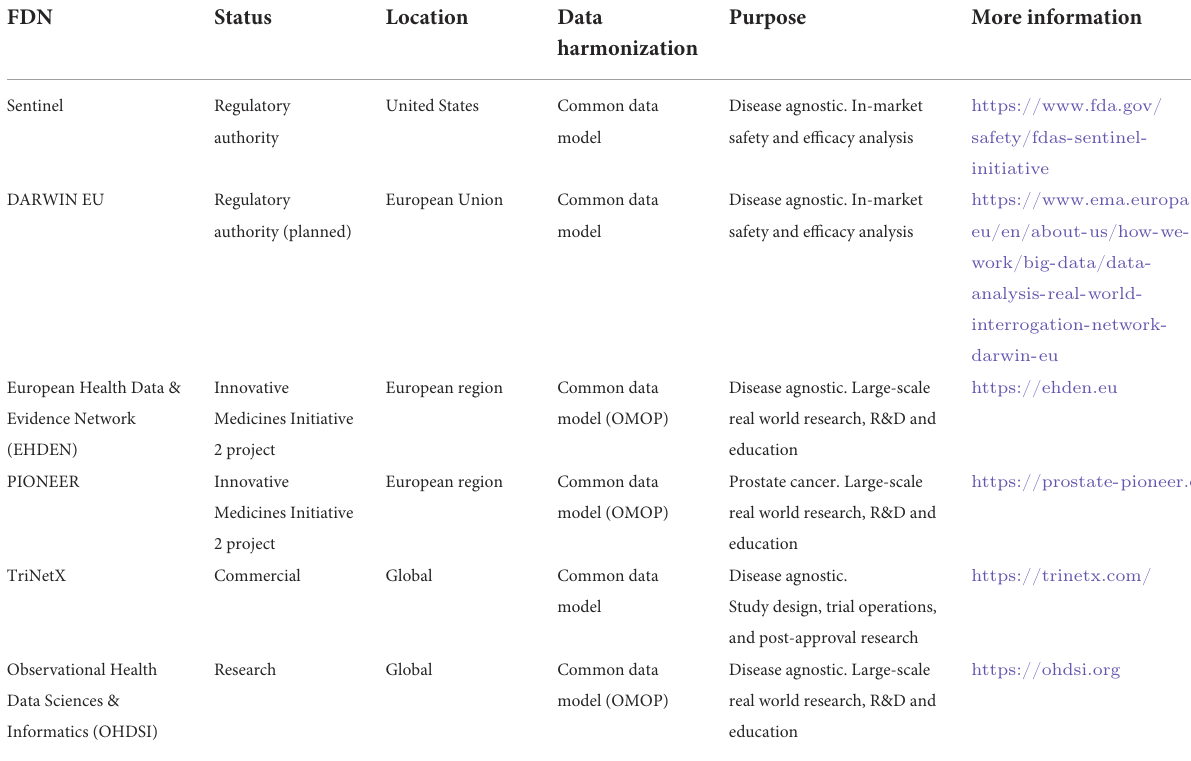
TABLE 1 Examples of international federated data networks for health